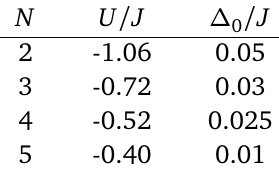
Table 1: Choice of parameters for the study of the quench dynamics. For a given particle number, we have chosen the interaction stregth and the barrier strength in such a way that the many-body bound state has the same size. All the calculations = are performed with N s